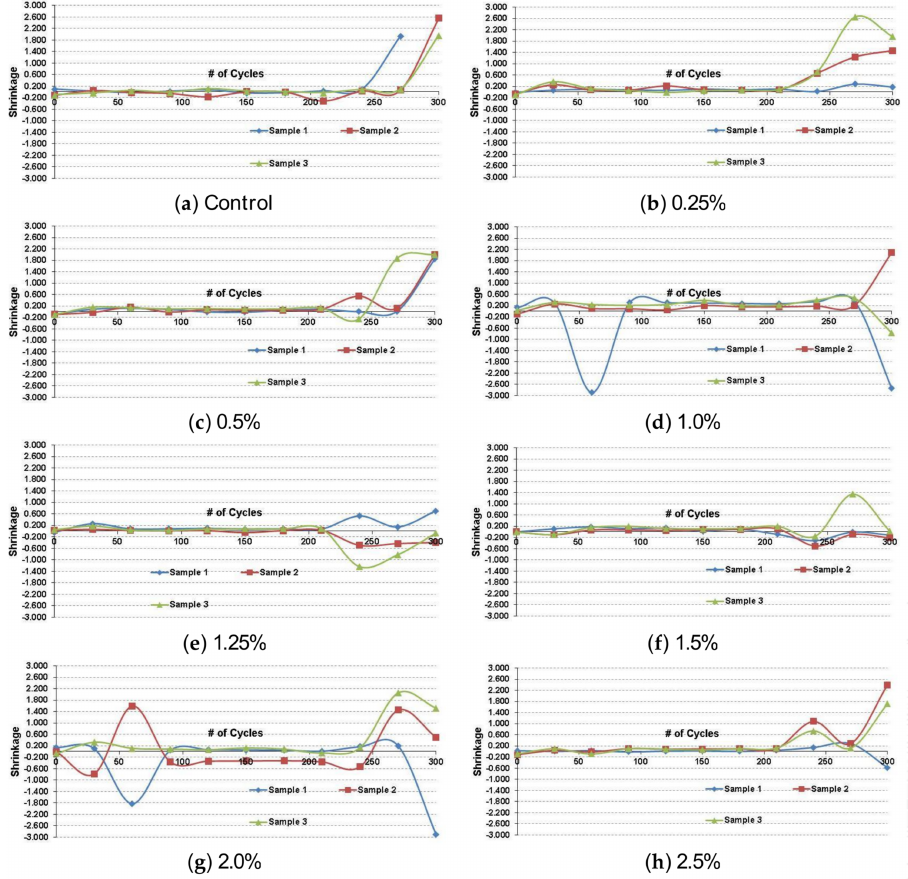
Figure 10. Shrinkage results due to freeze and thaw cycles.